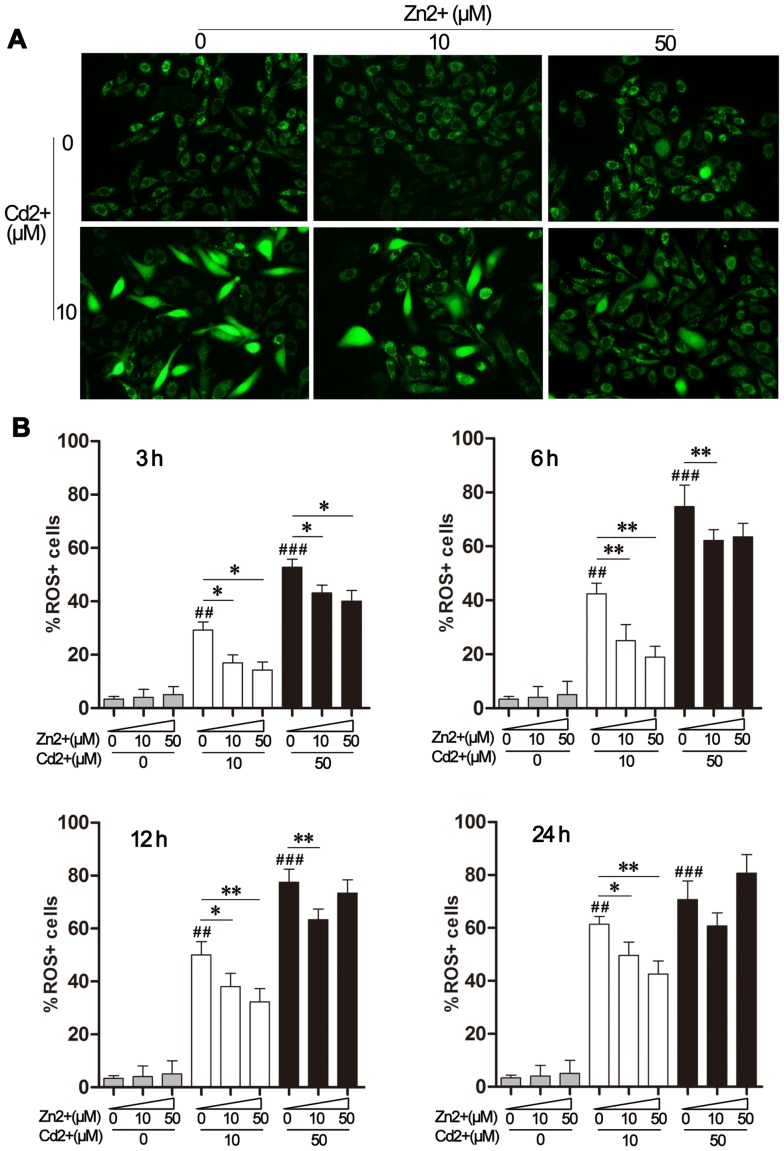
Effect of Zn2+ on Cd2+-induced accumulation of reactive oxygen species (ROS) in MDBK cells.(A) MDBK cells were treated with 10 μM CdCl2, alone or in combination with ZnCl2 (0, 10, or 50 μM), for 6 h. Intracellular ROS accumulation was assessed by DCFH-DA staining and imaged using a fluorescence microscope at ×200 magnification. (B) Cells were treated with Zn2+ and/or Cd2+ as indicated. Intracellular ROS was determined by flow cytometry following staining with DCFH-DA and the percentage of ROS-positive cells was quantified. The data represent the mean ± SD (n = 4). ##P<0.01, and ###P<0.001, compared to the medium-treated control group; *P<0.05 and **P<0.01 compared to the cells exposed to Cd2+ alone (10 or 50 μM).